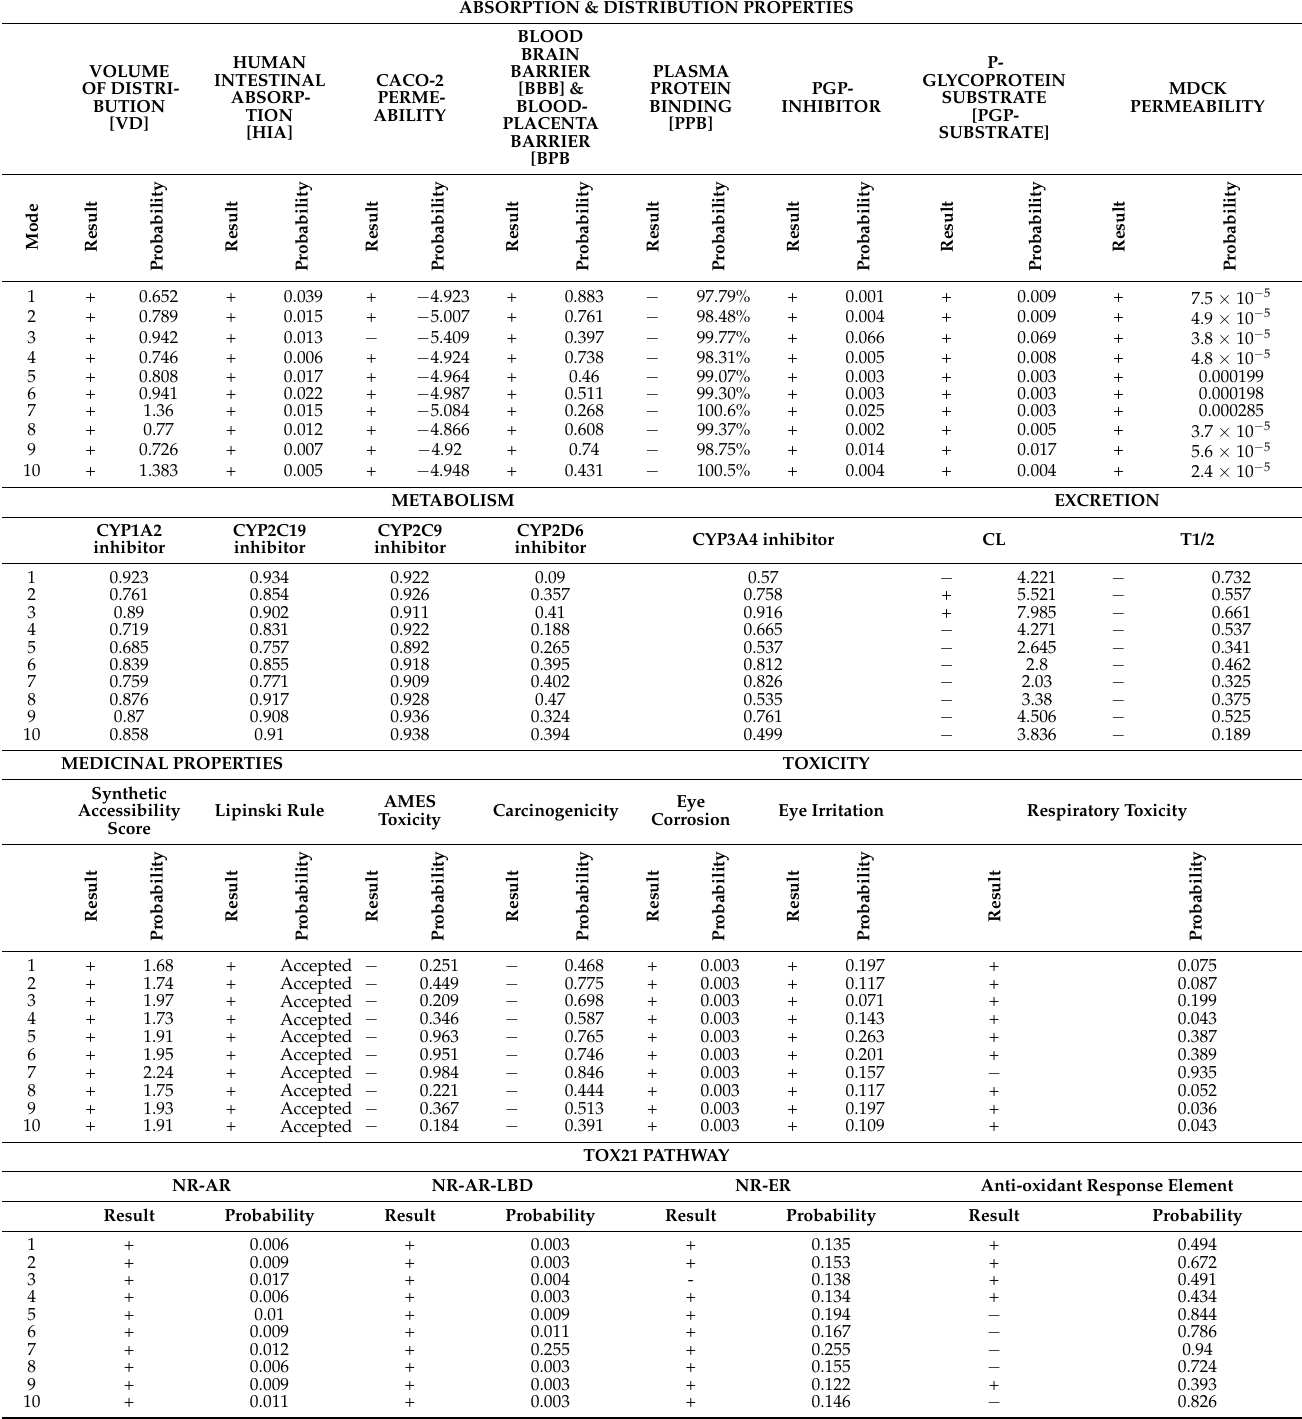
Table 5. ADMET properties of the selected